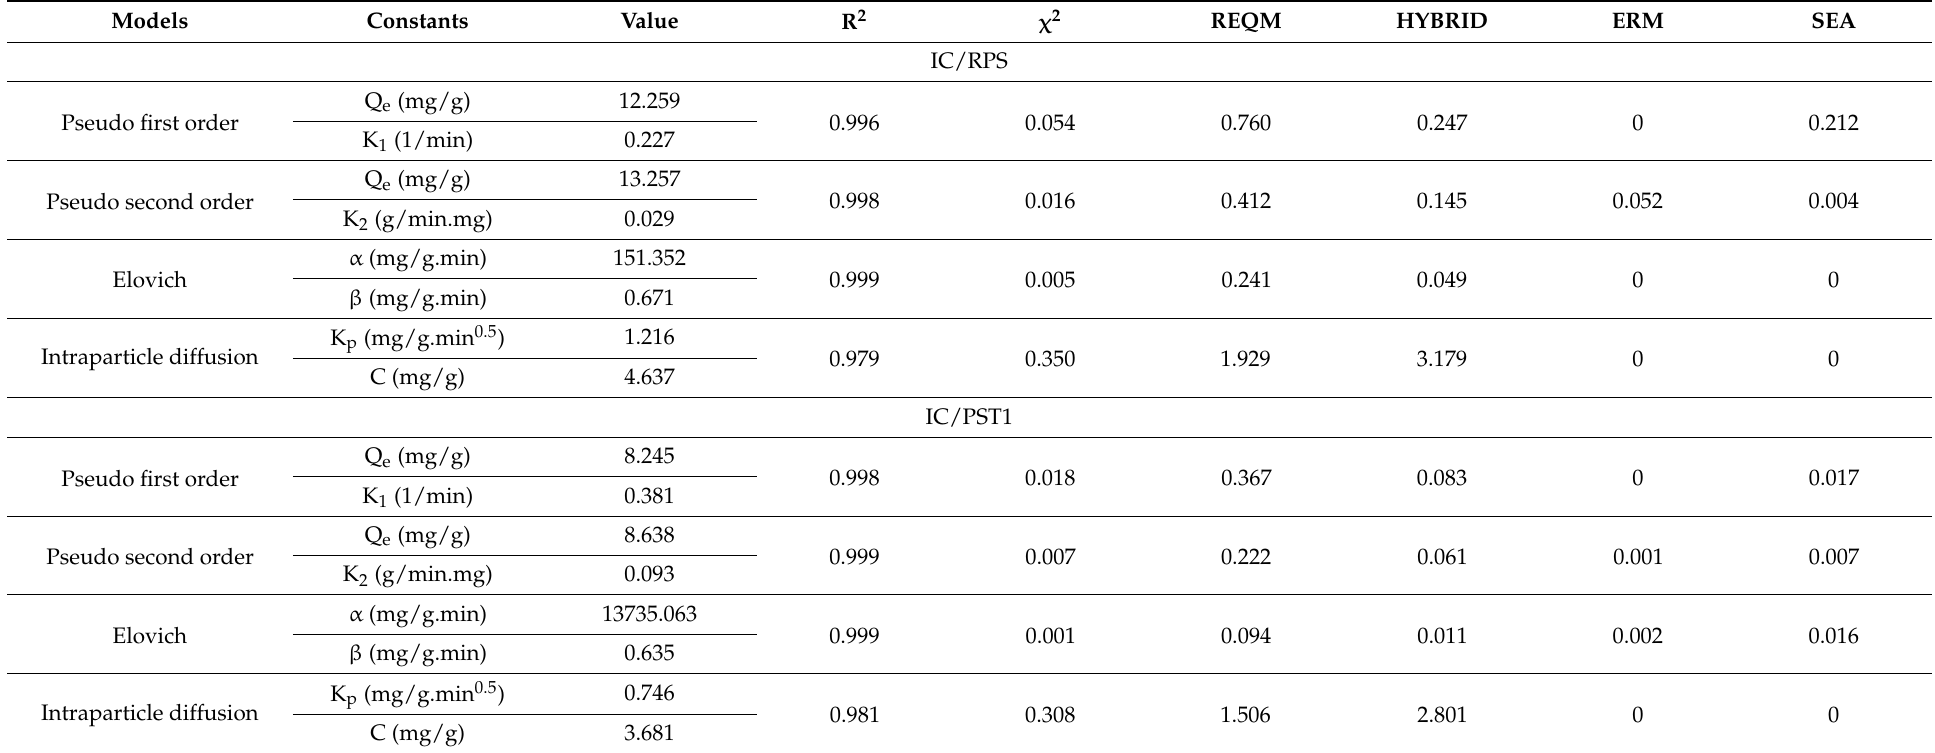
Table 6. Values of the constants of the nonlinear kinetics models for the biomasses RPS, PST1 and